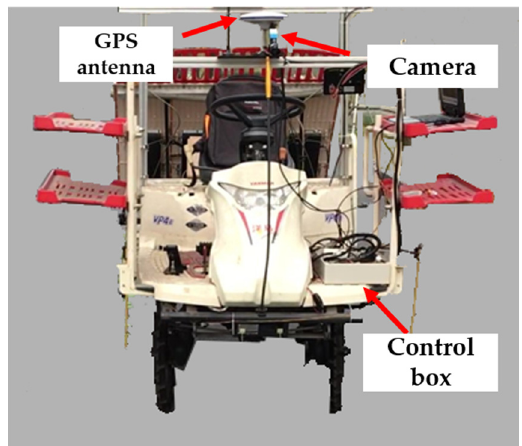
Figure 1. Transplanter platform and its machine vision system.